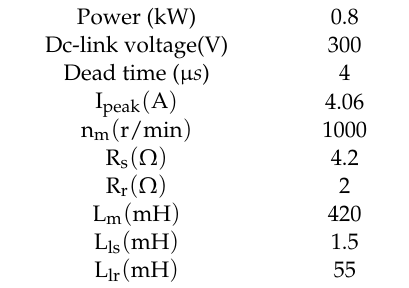
Figure 6. Experimental test bench. Table 1. Electric drive parameters.